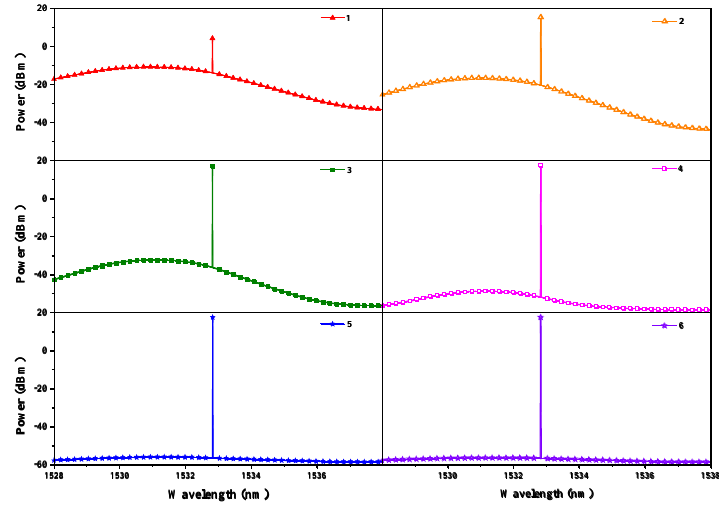
Figure 4. Spectra of the output laser in each iterative process.